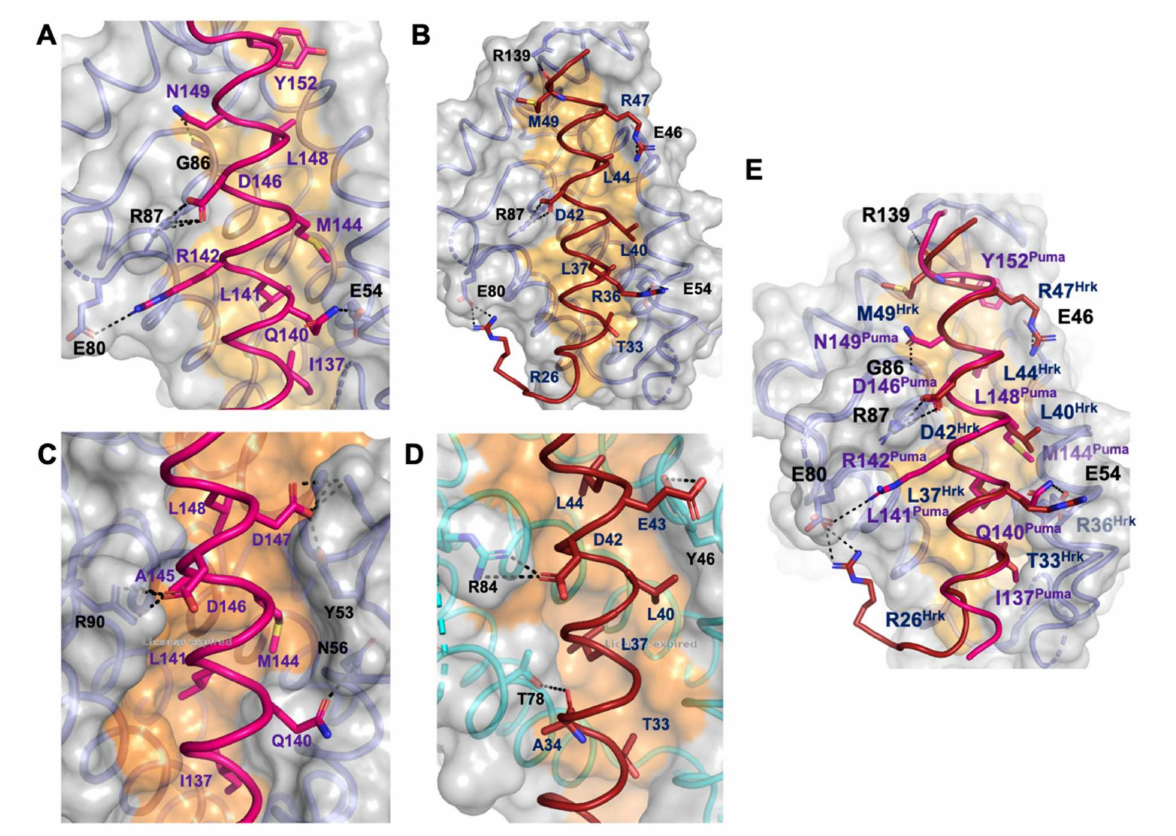
Figure 3. Detailed view of the ORFV125:Puma BH3, ORFV125:Hrk BH3, TANV16L:Puma BH3 and SPPV14:Hrk BH3 interfaces. The ORFV125 surface, backbone and floor of the binding groove are shown in grey, slate and orange, respectively. ( A ) ORFV125:Puma BH3 interface where Puma BH3 is shown in hot pink. The five key hydrophobic residues of Puma (I137, L141, M144, L148 and Y152) protruding into the binding groove, and the conserved salt bridge formed by ORFV125 R87 and Puma BH3 D146 are labelled, as well as all other residues involved in additional ionic interactions and hydrogen bonds. Interactions are denoted by dashed black lines. ( B ) ORFV125:Hrk BH3 with the surface of ORFV125 is shown as in ( A ), and Hrk BH3 is shown in brick red. The four key residues of Hrk BH3 (T33, L37, L40 and L44) are protruding into the binding groove, and the conserved salt bridge formed by Hrk D42 and ORFV125 R87 is labelled, as well as residues involved in hydrogen bonds. ( C ) TANV16 (sky blue):Puma BH3 is shown as in ( A ). The four key hydrophobic residues of Puma BH3 (I137, L141, M144 and L148) are protruding into the binding groove, and the conserved salt bridge formed by Puma D146 and TANV16L R90 is labelled, as well as residues involved in hydrogen bonds. Interactions are denoted by black dotted lines. ( D ) SPPV14 (cyan):Hrk BH3 is shown as in ( B ). The four key residues of Hrk BH3 (T33, L37, L40 and L44) are protruding into the binding groove, and the conserved salt bridge formed by Hrk D42 and SPPV14 R84 is labelled, as well as residues involved in hydrogen bonds. Interactions are denoted by black dotted lines. ( E ) Superimposition of Puma and Hrk BH3 complexes of ORFV125 as shown in panels ( A , B ). Key interacting residues are shown as sticks and are